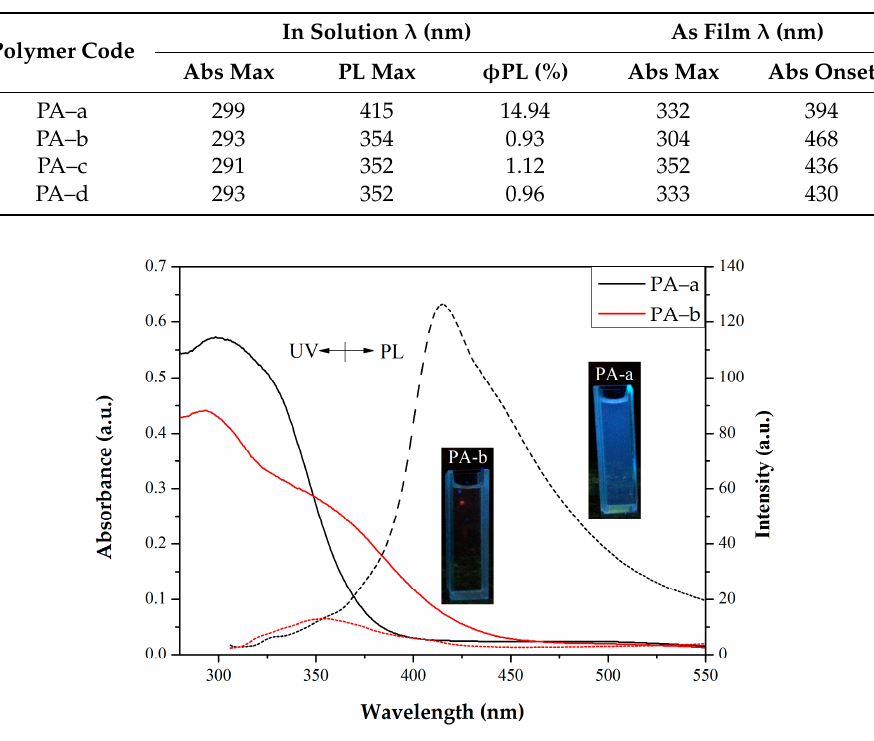
Table 2. Optical properties of PAs.